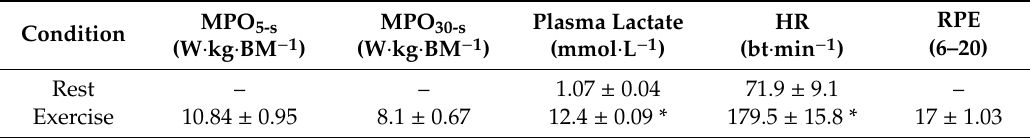
Table 1. The subjects selected parameters under rest and / or exercise